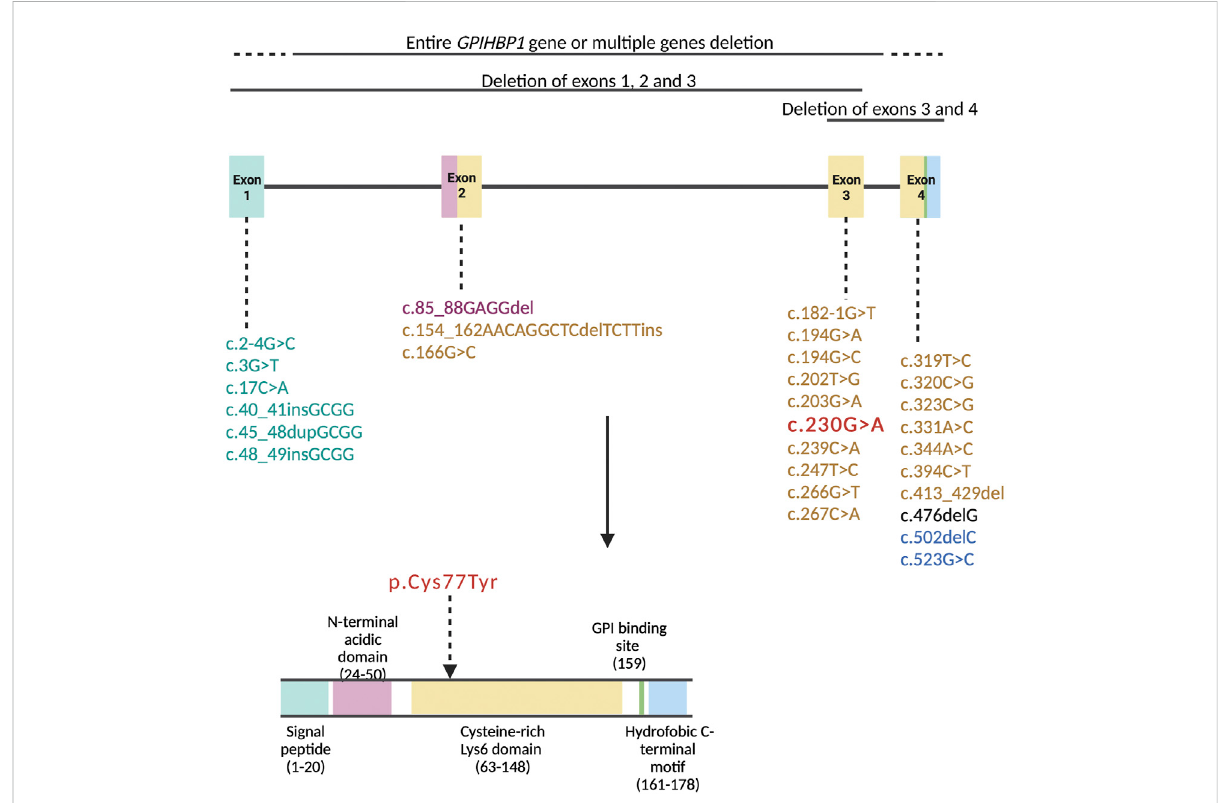
FIGURE 3 Pathogenic variants in the GPIHBP1 gene based on the literature review represented in Table 1 are organized by exon numbers. The colour of the exon denotes the protein domain affected by the pathogenic variation. The variant of our patient (c.230G > A) is in bold red